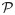
Local analysis of the time reversion statistical symmetry for the currency pair USD/JPY in the week from 2011, October, 30th to 2011, November, 5th.(a-1) Mid-quote time series in tick time with intervals evaluated as time reversion asymmetric shown in orange (for window size w = 1000). (a-2) Color plot showing window size effect on the hypothesis test; color code refers to the decimal logarithm of the probability P and points are colored only if P is below the threshold 10−7, i.e., if they are classified as time reversion asymmetric. (b-1) and (b-2) details the Japanese government intervention; red box indicates the quick increase in the mid-quote and the blue box the period of almost constant mid-quote. Time reversion asymmetric intervals only occur during the intervention and a short period right after it.